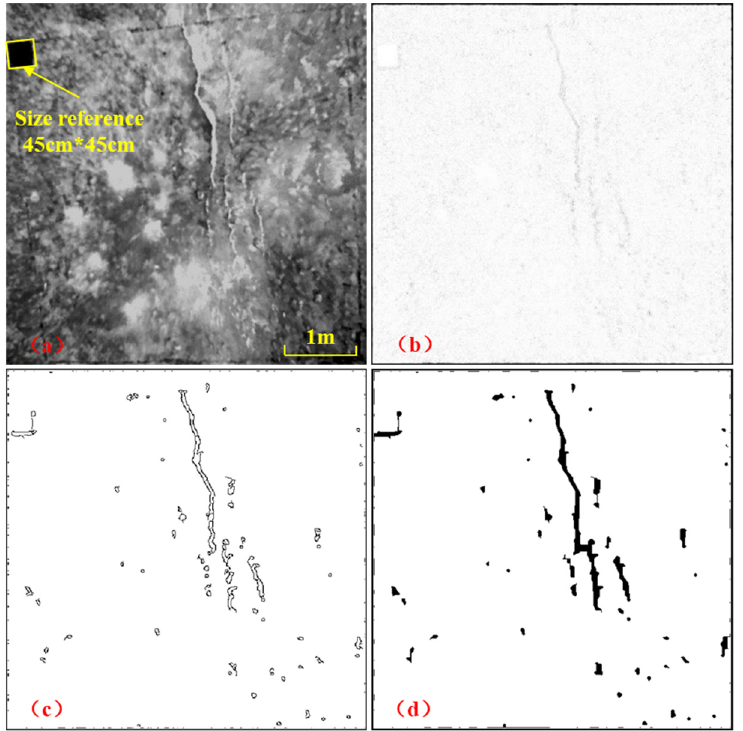
Figure 2. Diagram of edge detection process with the proposed method. ( a ) Input image. ( b ) Result of LoG filter in step 1. ( c ) Result of Canny operator in step 2. ( d ) Result of closed operation in step